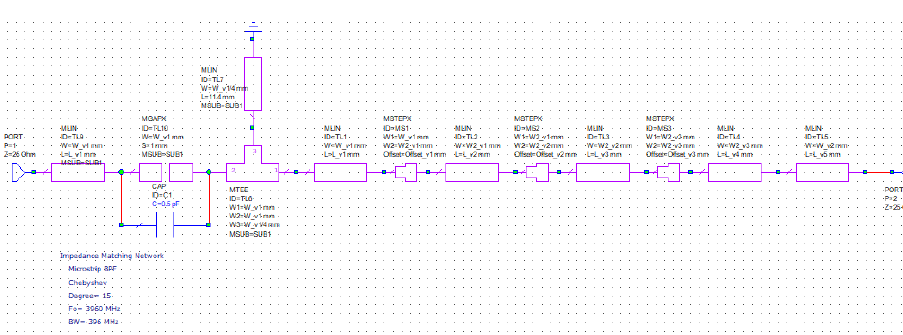
Fig. 4. Electrical circuit of input matching the amplifier